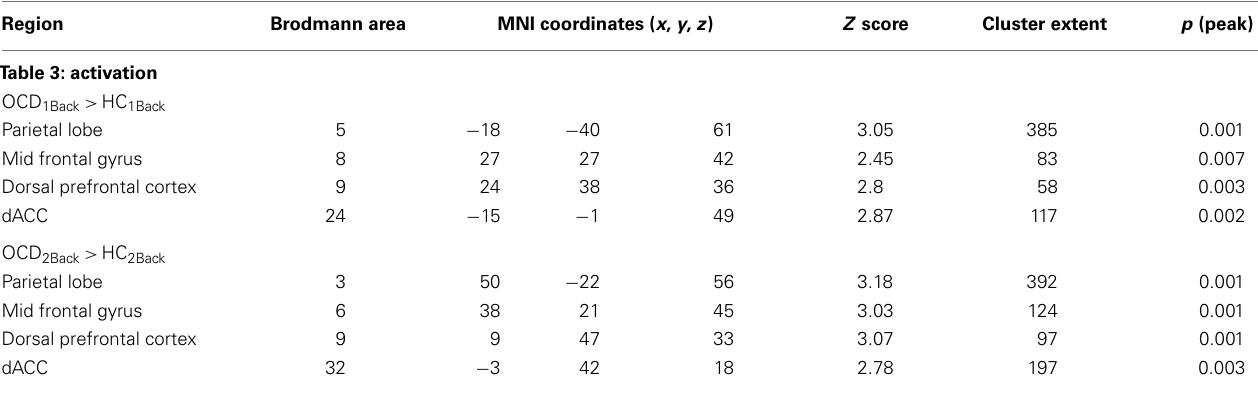
Table 3 |The table provides information regarding clusters of significant and significant peaks showing dysfunctional activation profiles in OCD (compared to HC) at each level of memory load (Figure 3)